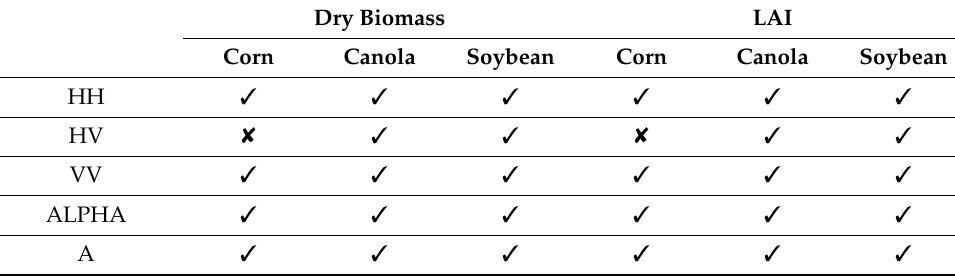
Table 7. SAR and Optical features used for different crop parameter